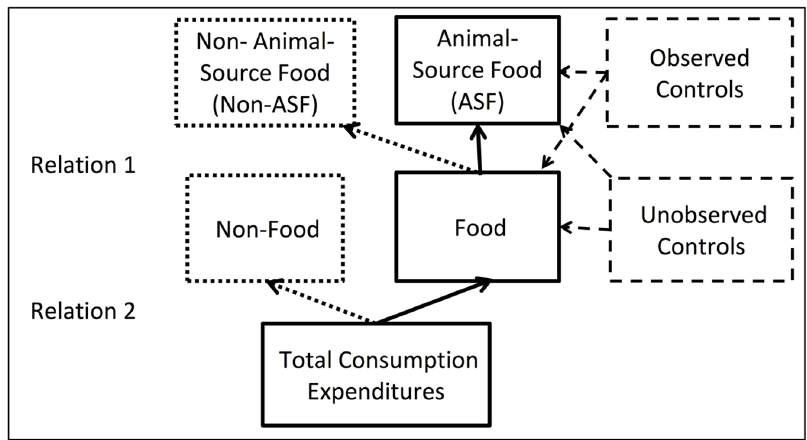
Figure 1. Framework for Analysis. Relation 1 represents the division of food expenditures between ASF and non-ASF, as shown in the top row. Relation 2 represents the division of total expenditures between food and non-food expenditure, as shown in the middle row. We focused our attention on the solid arrows between the center boxes in the figure. Observed controls (dashed boxes on the right) included other important determinants of ASF and food consumption expenditures, such as maternal schooling [31,49], paternal schooling and community wealth. Unobserved controls included other household characteristics, such as food preferences.